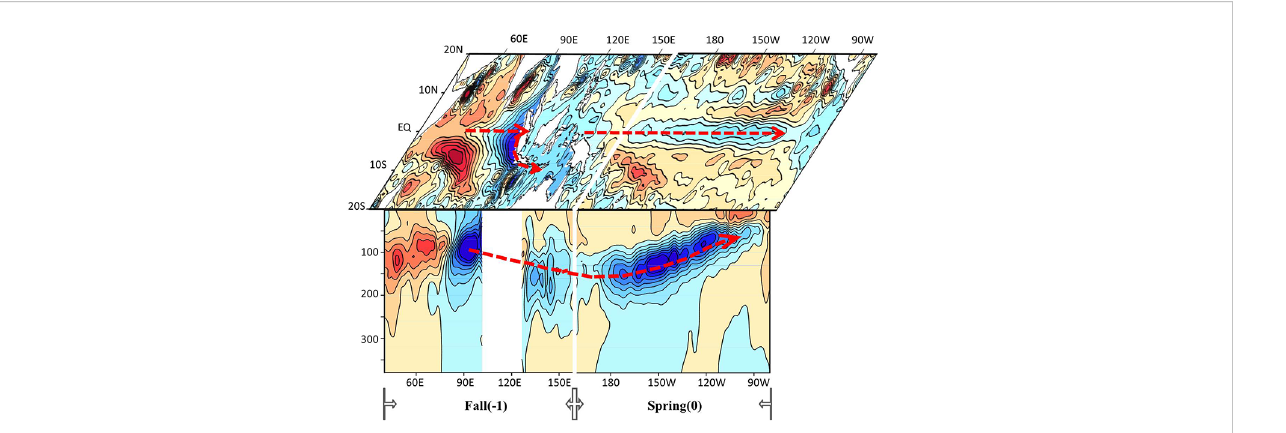
FIGURE 15 Schematic illustration for the negative SETIO SLA as a predictor of the La Niña events based on the tropical Indo-Paci fi c “ ocean channel ” dynamics. The upper (lower) part of this fi gure shows the SLA (subsurface temperature anomalies). The left (right) part of this fi gure shows the condition during the peak of pIOD (following spring). The red dashed arrows indicate the eastward-propagating Kelvin